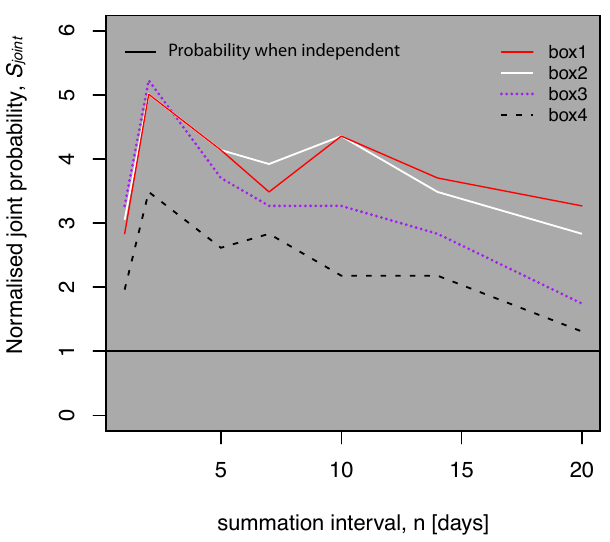
Fig. 5. Summary of effect of changing North Sea box dimensions on the normalised joint probability S joint (exceedances of the clima- tological q w ) for NNW wind component (1950–1980). Configu- 0 . 99 rations of the four North Sea boxes can be seen in Fig. 1 with the same colour